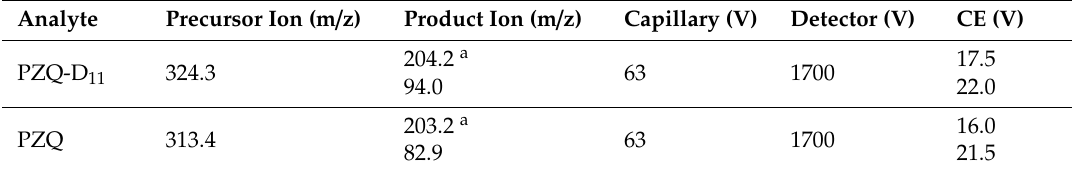
Table 1. Optimized instrumental